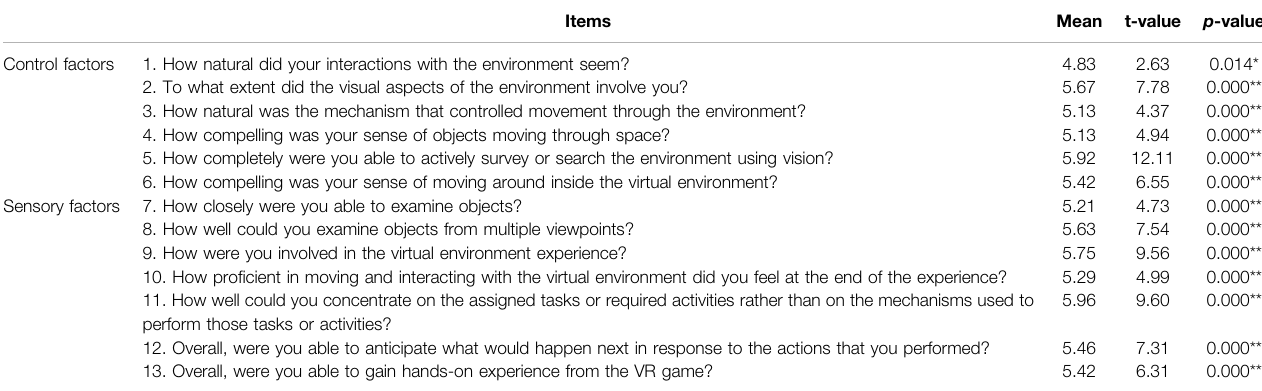
Items Mean t-value p -value